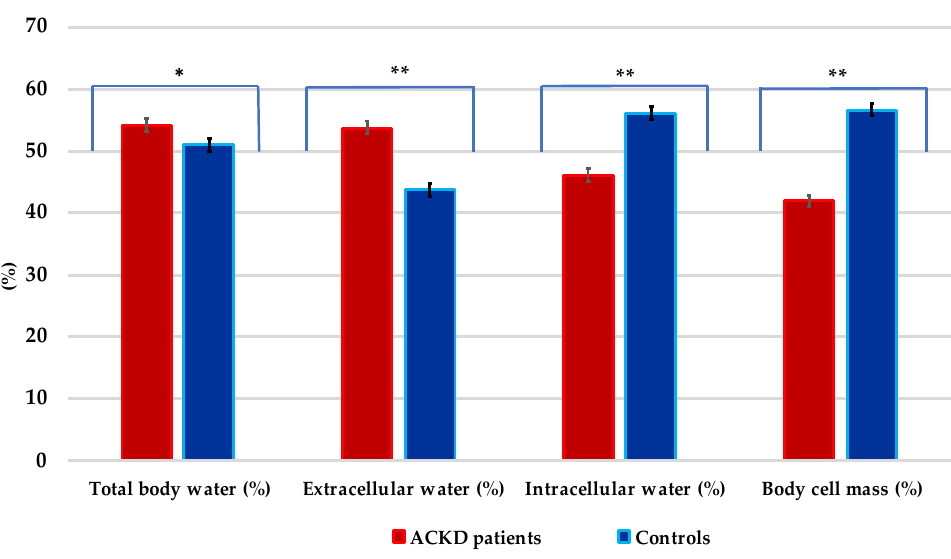
Figure 2. Distribution of the hydration status in patients with advanced chronic kidney disease and controls. * p = 0.006; ** p < 0.001. Values are expressed in percentages (%). Cases had significantly lower mean values of BCM, FM, MM, and PA than controls